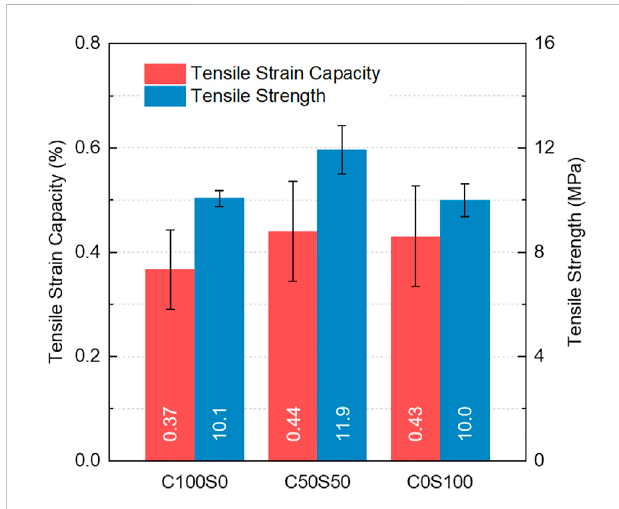
FIGURE 9 Summarized tensile performances of SH-UHPGC with different activators.